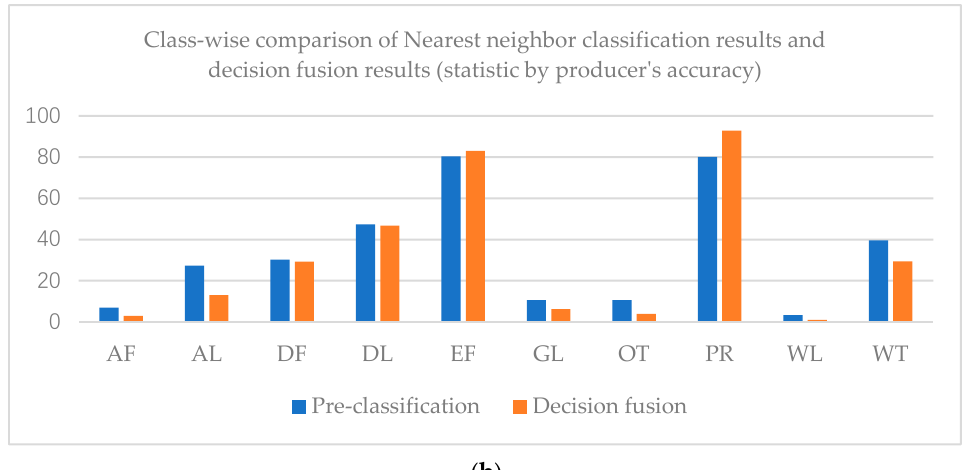
Figure 9. Class-wise comparison of nearest neighbor classification results and decision fusion results (statistic by user’s accuracy ( a ) and producer’s accuracy ( b )) in the Mun River Basin.